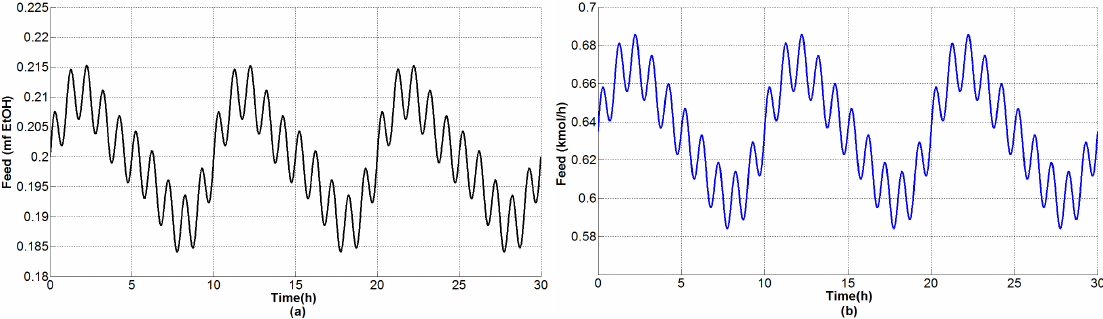
Figure 11. Continuous fluctuating perturbation on ( a ) feed ethanol composition and ( b ) feed flow